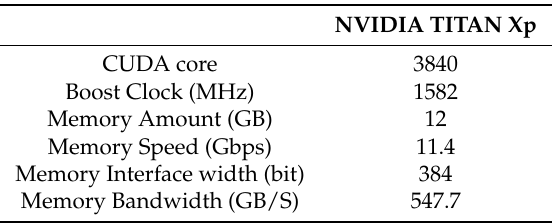
Table 1. Main GPU features.